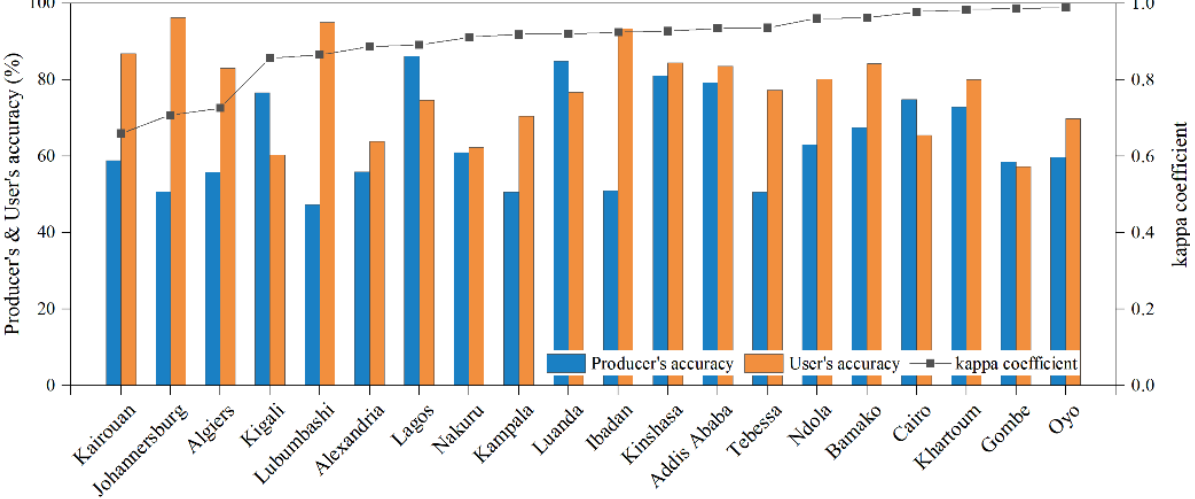
ISPRS Int. J. Geo-Inf. 2021 , 10 , x FOR PEER REVIEW Figure 6. Comparison among land use maps for 2014 from The Atlas of Urban Expansion (2016 Edition) ( a ) and MCD12Q1 ( b ); distribution of nighttime light types for 2014 ( c ); urban land for 2014 generated from LandScan ( d ).